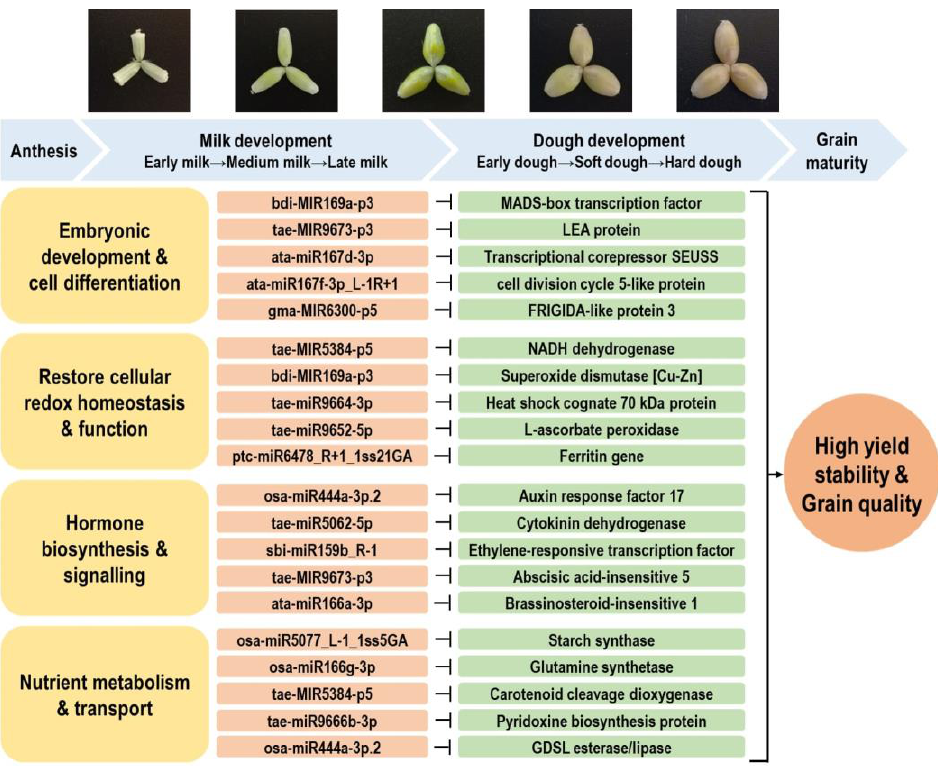
Figure 7. Key miRNA–RNA modules contributing to water deficit and heat stress response and grain development in durum wheat. Abbreviations: MADS domain (MCM1, AGAMOUS, DEFICIENS, SRF). LEA protein (late embryogenesis abundant protein). GDSL motif (Gly–Asp–Ser–Leu).